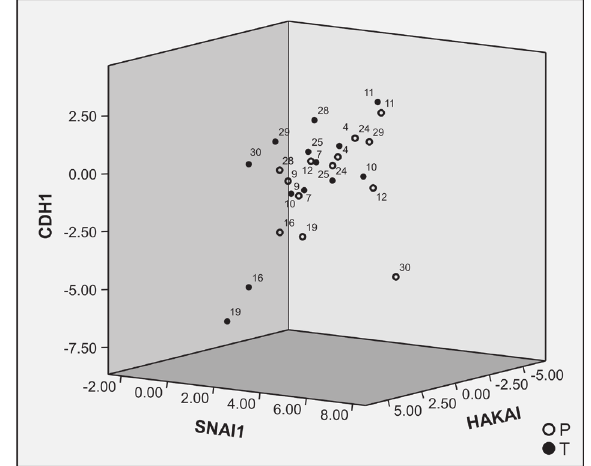
Figure 3. Three-dimensional distribution of tumor (T) and peritu- moral (P) samples according to CDH1, SNAI1 and HAKAI mRNA expression. Thirteen patients had all three target genes evaluated in matched samples. Discriminant analysis classified 65.4% of the samples in the correct group.